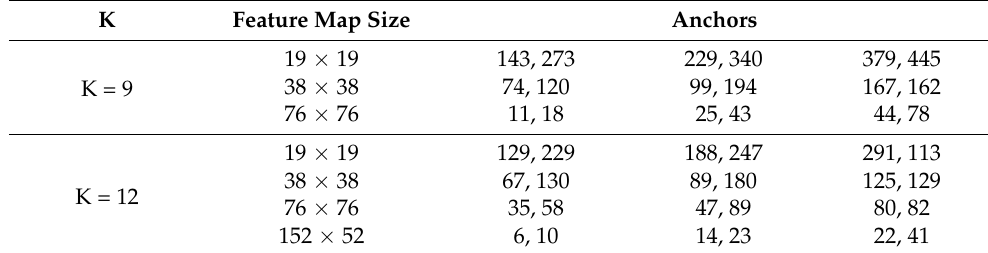
Table 1. The candidate boxes after